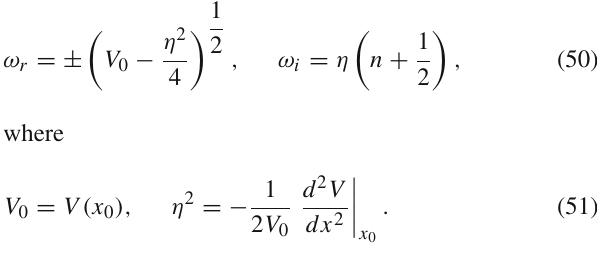
Fig. 4 The solution without horizon (left panel) and Schwarzschild-like black hole solution with horizon radius r + = 1 . 4 (right panel) in terms of r for α = 1 , H = − 0 . 047 , c = 1, 1 0 and α = 0 . 5 , H = − 1 , c = − 2 , 1 0 9 respectively. At both cases we set c 1 = − 0 . 1406